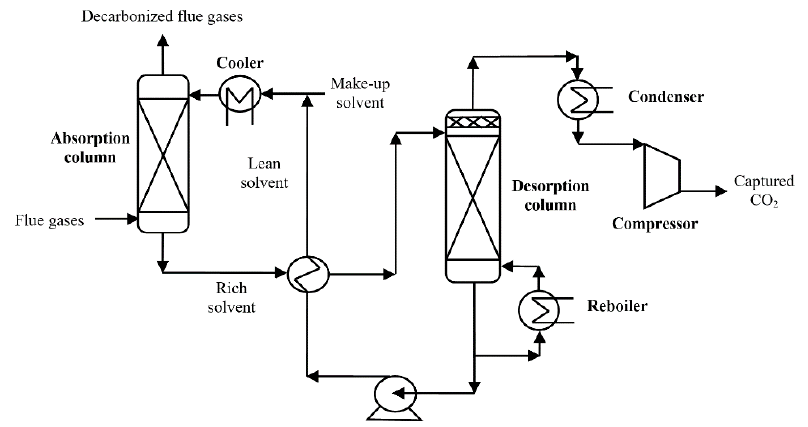
Figure 1. CO 2 capture plant by chemical absorption-desorption cycle (benchmark).